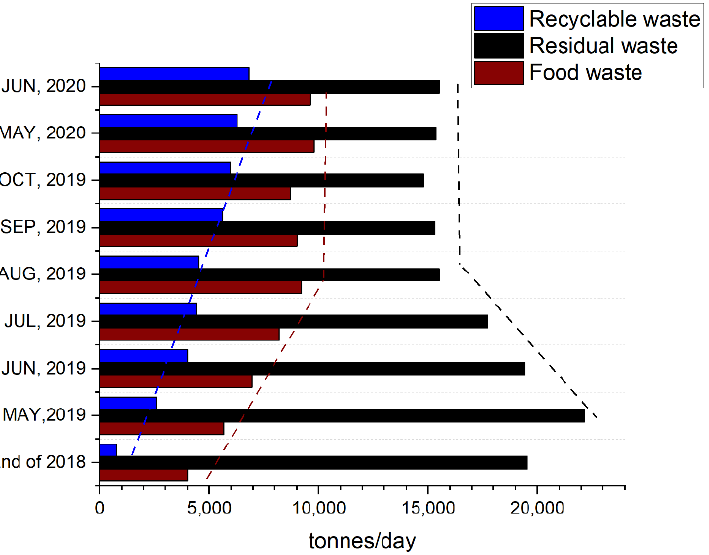
Figure 2. Changes in daily tonnages of different waste streams in Shanghai before and after the new compulsory regulations of July 2019.